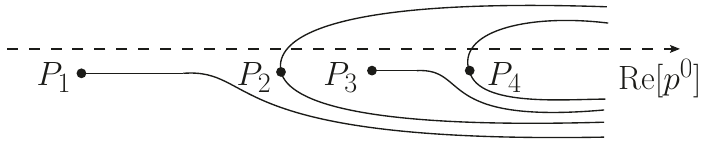
Figure 5 . Standard and LW thresholds close to the real